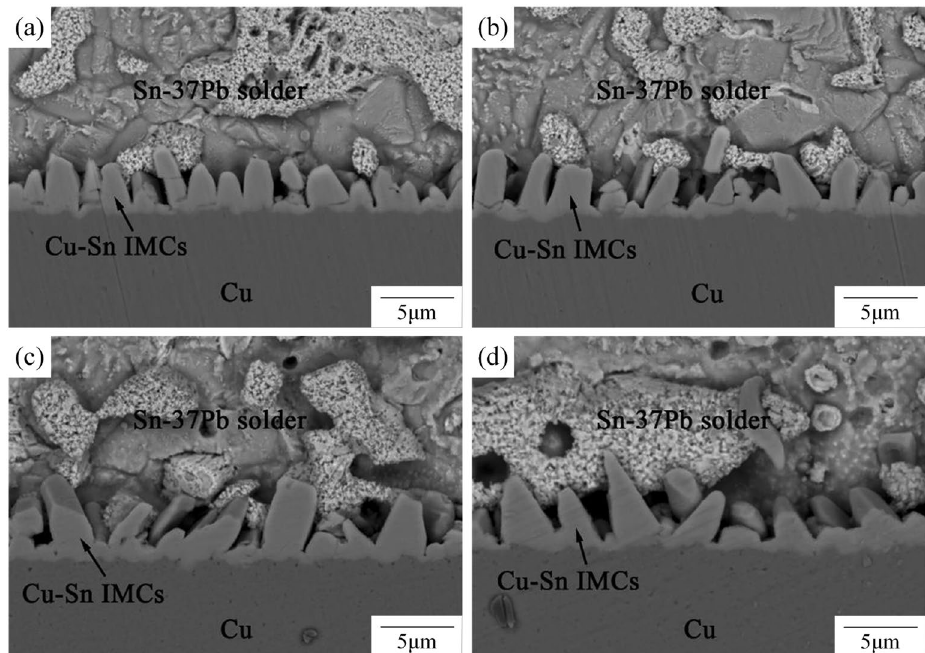
Figure 3 Interfacial microstructure of Sn-37Pb/Cu solder joints stored at